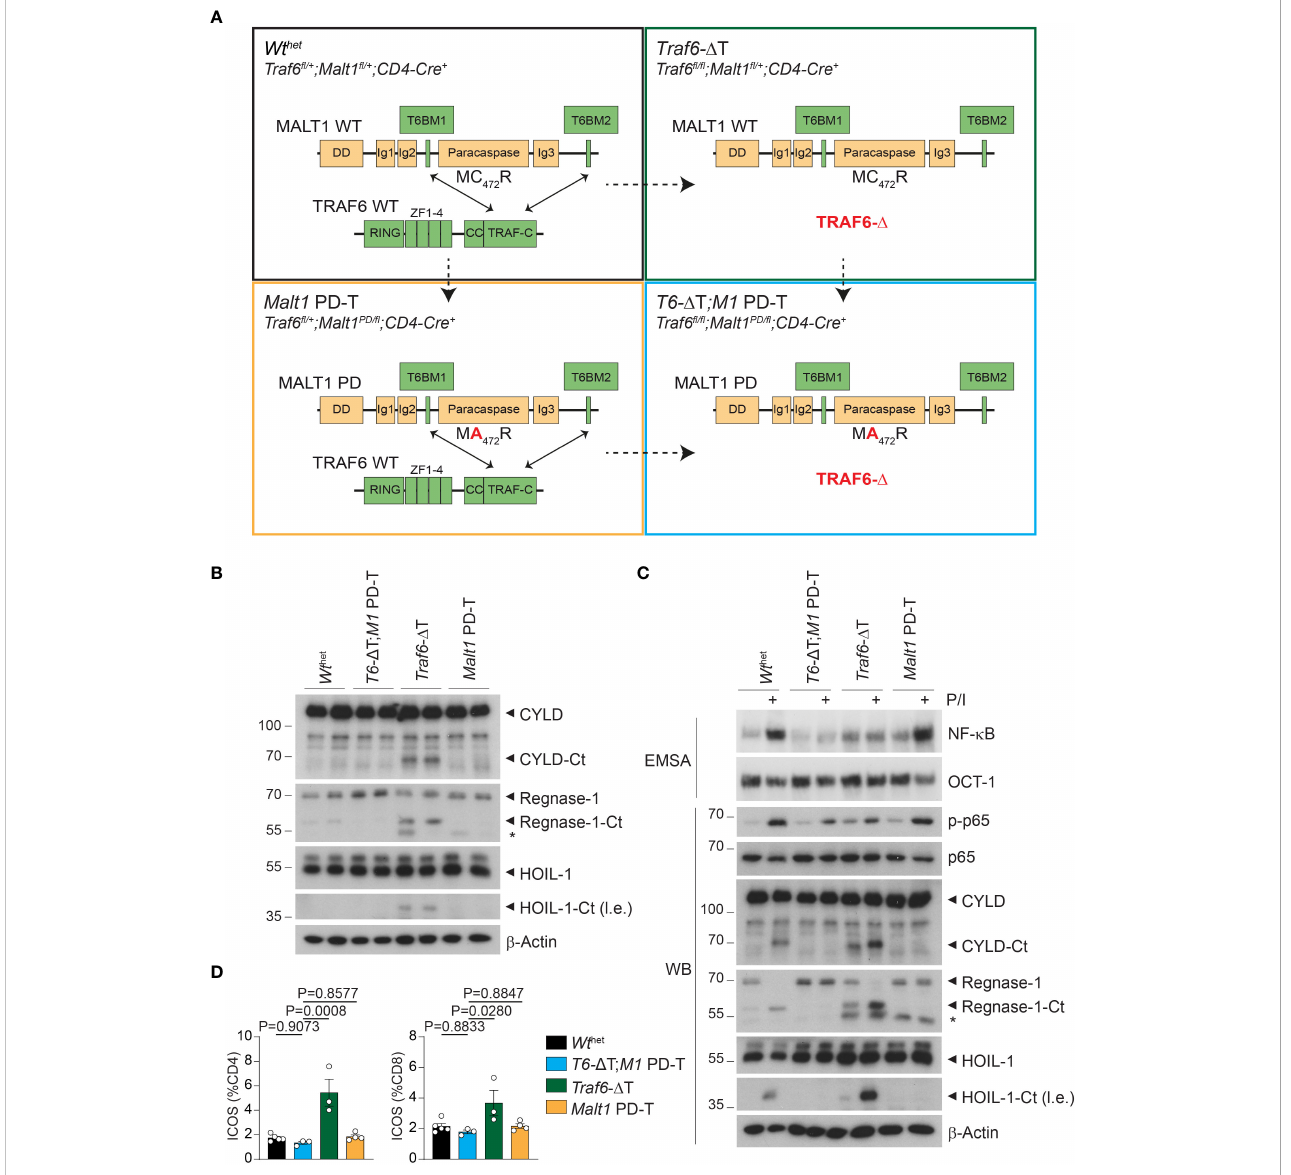
FIGURE 1 Effects of single or combined TRAF6 KO and MALT1 paracaspase mutation on signaling in CD4 + T cells. (A) Schematic overview of the four conditional mouse strains used in the analyses. (B) Western blots showing MALT1 substrate cleavage in unstimulated puri fi ed CD4 + T cells from Wt het , T6- D T; M1 PD- T, Traf6 - D T and Malt1 PD-T mice (two independent mice each). Asterisks indicate unspeci fi c signals. (C) Analyses of NF- k B activation (EMSA), p65 phosphorylation and MALT1 substrate cleavage (Western blot, WB) in PMA/Ionomycin (P/I) stimulated puri fi ed CD4 + T cells of mice as depicted in (A) . (D) Expression of ICOS on CD4 + and CD8 + T cells by fl ow cytometric analysis of spleen of mice as depicted in (A). Bars show the means ± SEM, and P values were calculated by one-way ANOVA with Tukey ’ s multiple comparison test. All analyses were performed with mice 9-11 weeks of age. Each dot represents one mouse. Ct, C-terminus; l.e., long